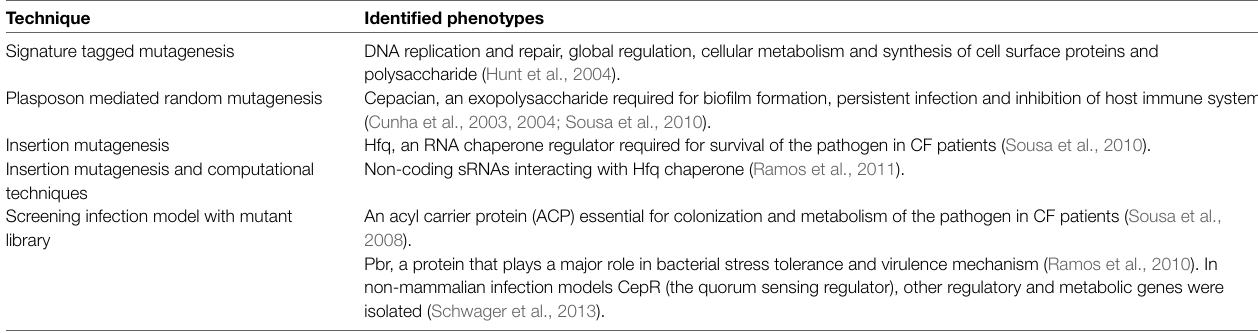
TABLE 1 | Bcc physiologic and virulence traits identified by classical screening approaches. Technique Identified